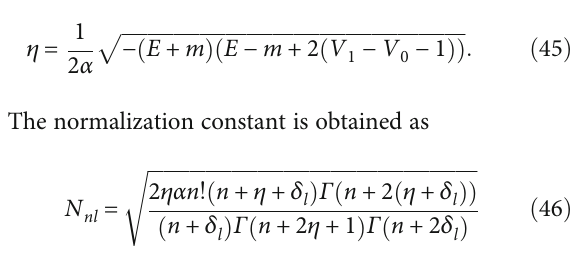
Table 3: The energy levels of the Eckart plus Hulthen potential for several states with l = 0, α = 0 : 05 , in atomic units ℏ = μ = 1